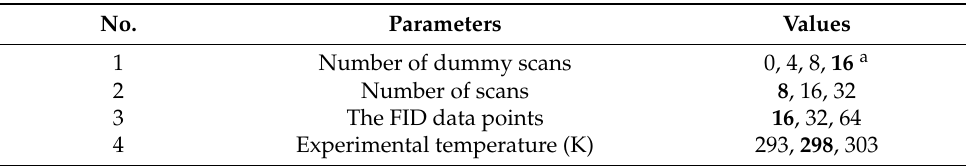
Table 1. Summary of all of the examined parameters and their variation ranges . No. Parameters Values 1 Number of dummy scans 0, 4, 8, 16 a 2 Number of scans 8 , 16, 32 3 The FID data points 16 , 32, 64 4 Experimental temperature (K) 293, 298 , 303